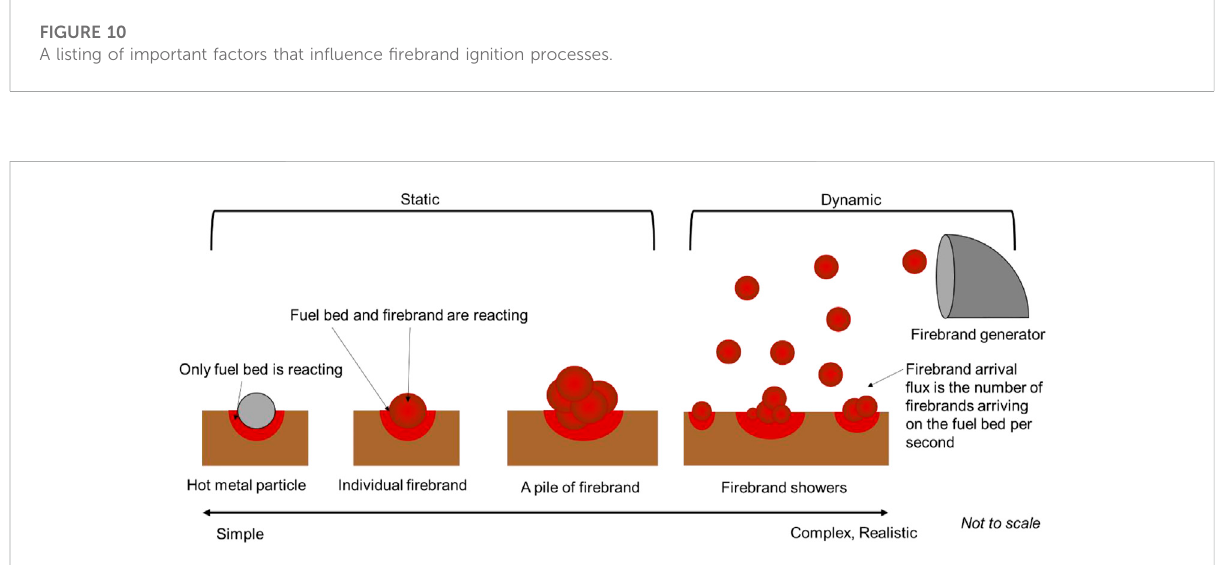
FIGURE 11 A basic overview of approaches undertaken in fi rebrand ignition